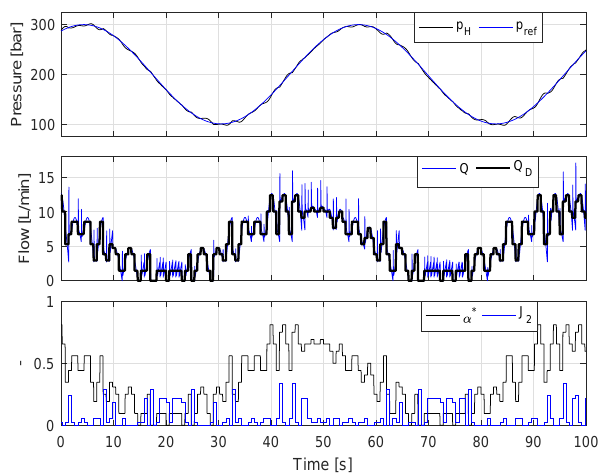
Figure 11: Pressure tracking response using the DEA MPC algorithm with the energy cost func- tion.